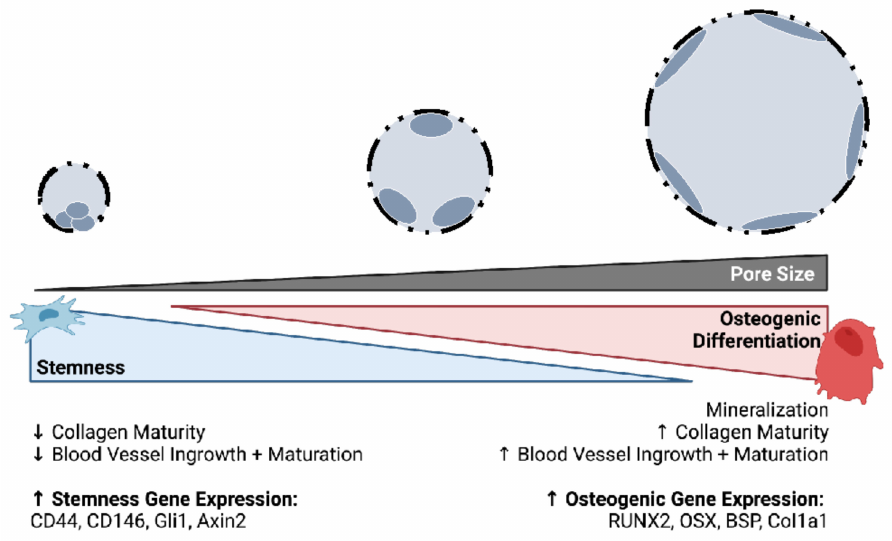
Scheme 1. Scaffold macropore diameter modulates tissue phenotype and gene expression, in vitro and in vivo (Ref: Swanson et al., Biomaterials 2021 [28]). Upward arrows indicate upregulation, downward arrows indicate